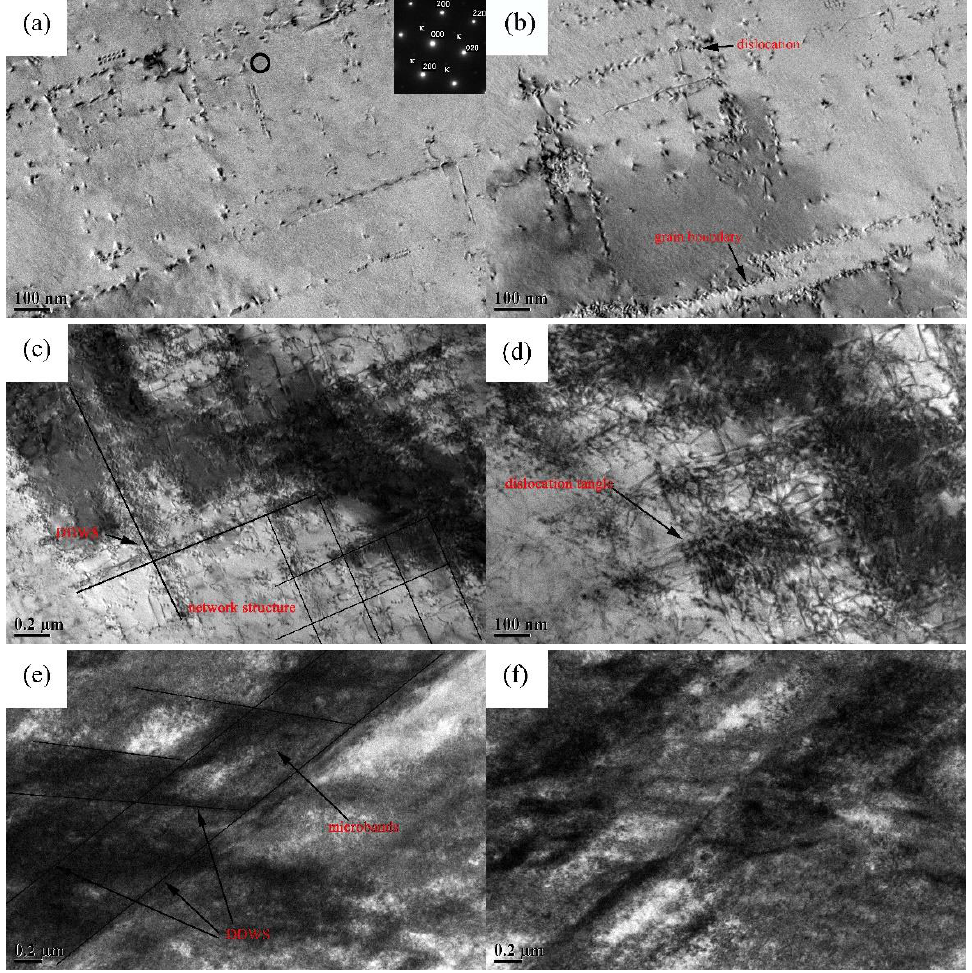
Figure 4. TEM micrographs showing the microstructure of steel at di ff erent strain; ( a ), ( b ) 10%; ( c ), ( d ) 30%; ( e ), ( f ) after failure at